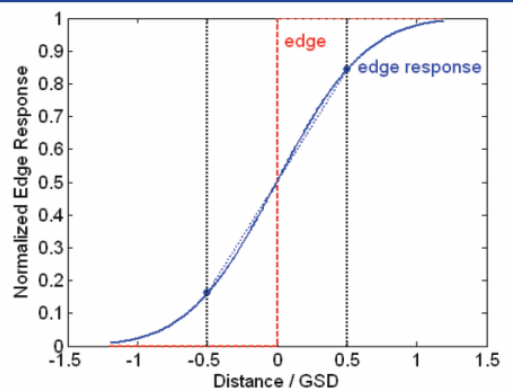
Figure 5: a profile used to calculate the relative edge